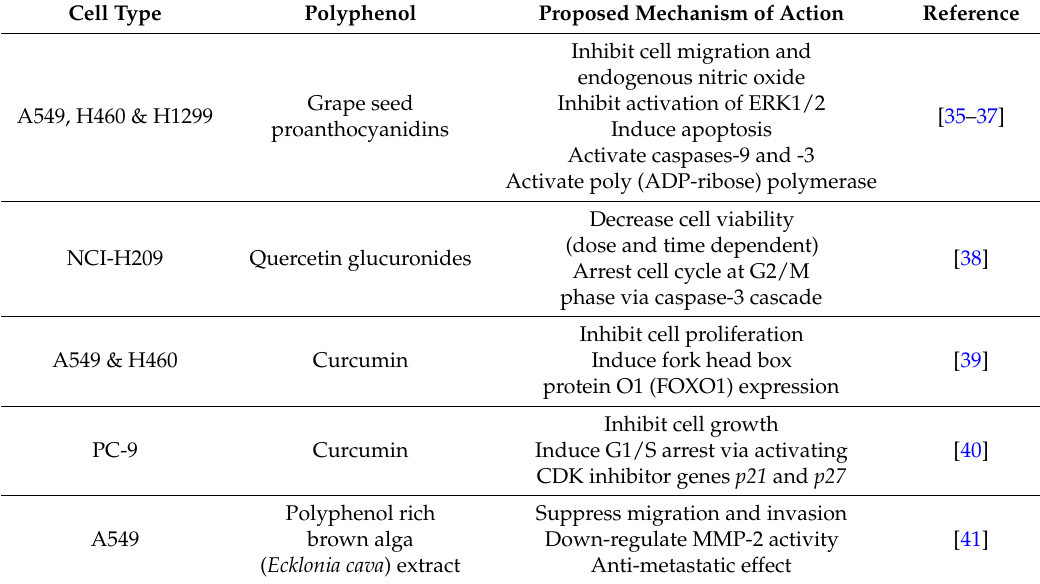
Table 1. In vitro studies of anti-proliferative effect of polyphenols in lung